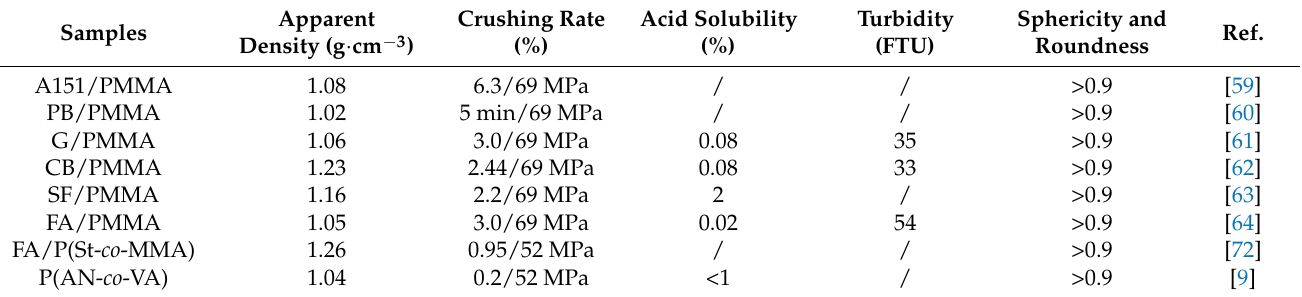
Figure 11. Schemes of the synthetic process of poly(St- co -MMA)/FA composite proppant [72]. Table 8. Properties of PMMA based